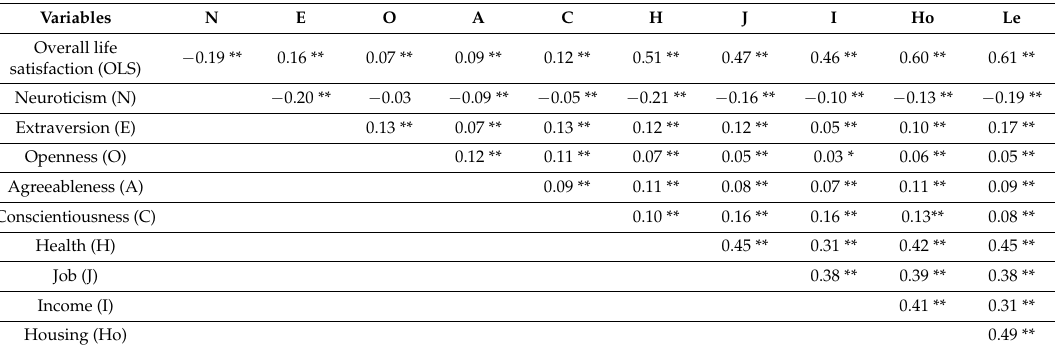
Table 5. Correlations of personality (BFI-10) and satisfaction variables for Survey 2. ( N = 4784 except for variable job: N = 4390).